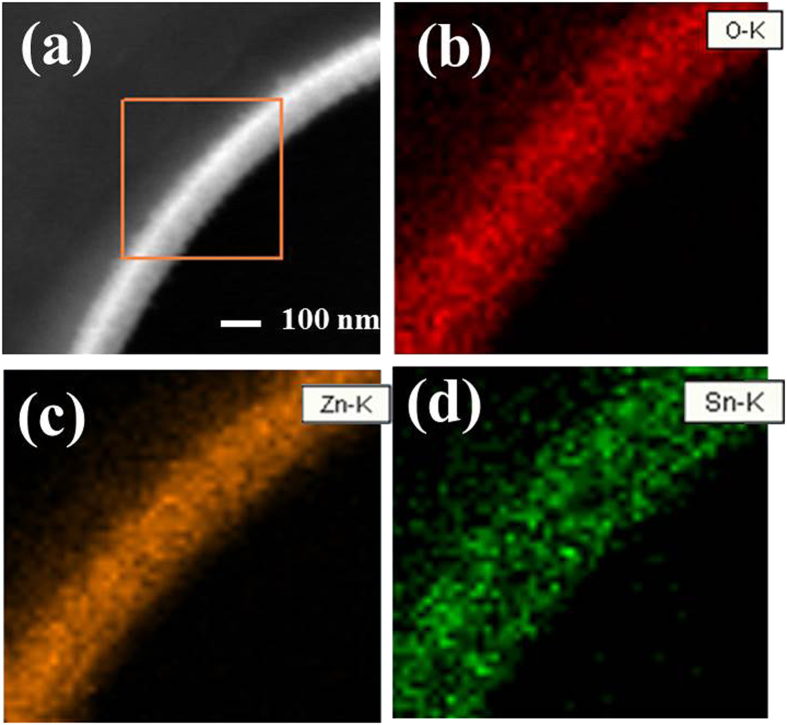
(a) A magnified TEM image of a typical SnO2/ZnO heterojunction, and the corresponding (b) O Kα1 map, (c) Zn Kα1 map and (d) Sn Kα1 map.